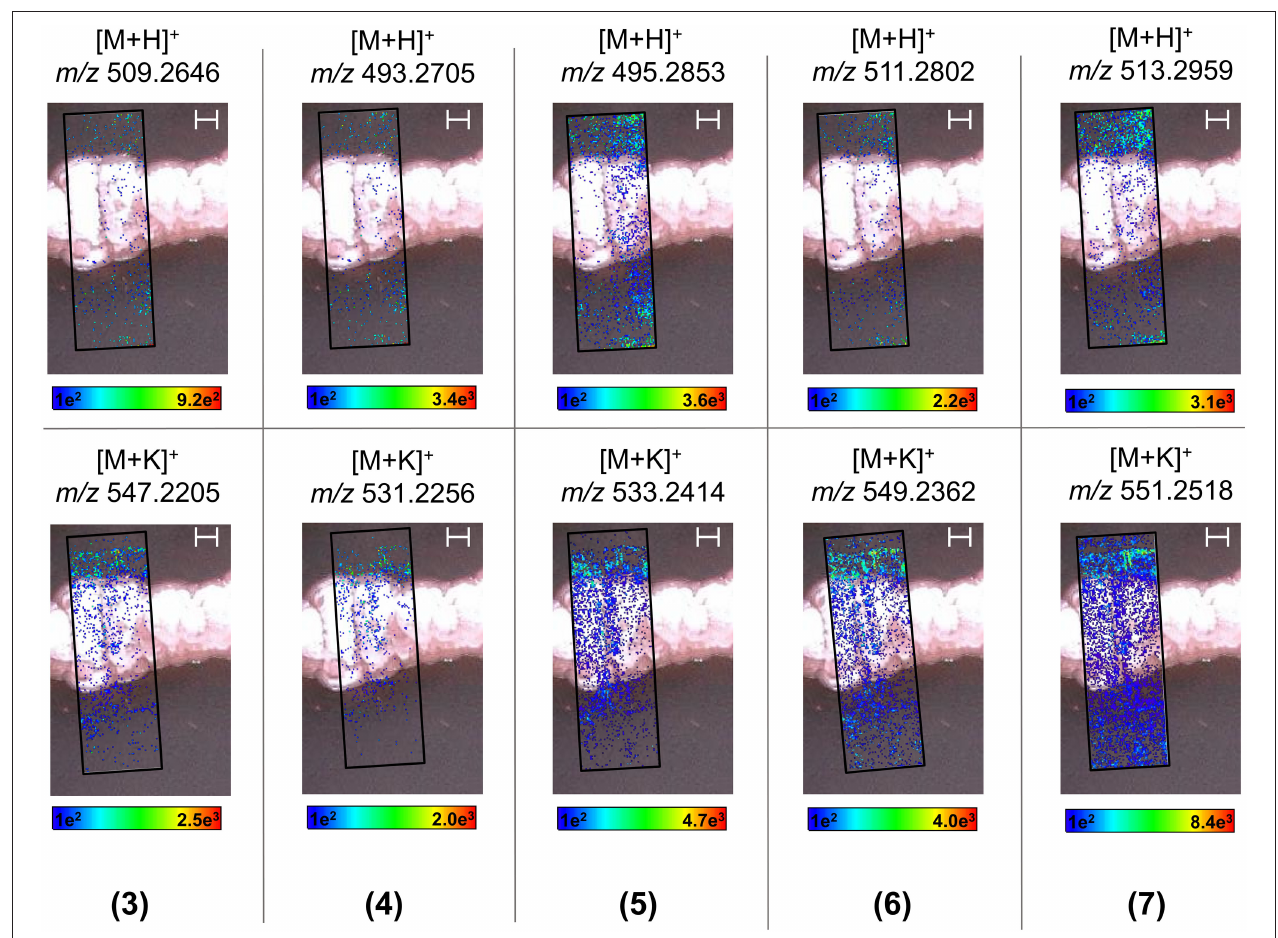
FIGURE 6 | MALDI-HRMSI of PTMs (compounds 3–7 ) produced by endophytic S. pulveraceus ES16. Selected ion images depict the localization and distribution of the PTMs ([M + H] + and [M + K] + ; ± 5 ppm; spatial resolution = 30 µ m; matrix used = MBT) after cultivation on PDA for 14 days. The assigned scale bar represents 1,000 µ m. The black insert depicts the scanned area in each